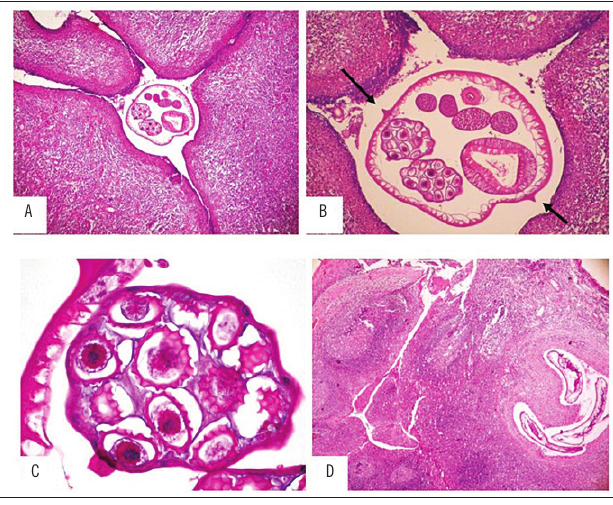
figurE 2 − Histological sections of the lymph node and the tonsil A) adult worm inside the lymph node (HE, 40 × ); B) detail of adult worm inside the lymph node, showing the lateral alae (arrow) (HE, 100 × ); C) note a detail of the Lagochilascaris eggs with “soda cap” appearance (HE, 400×); D) adult worms in the tonsil (HE, 40×). HE: hematoxylin and eosin.